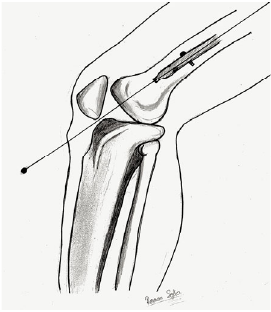
Figure 6. The retrograde ball ‐ tipped guide wire principle.